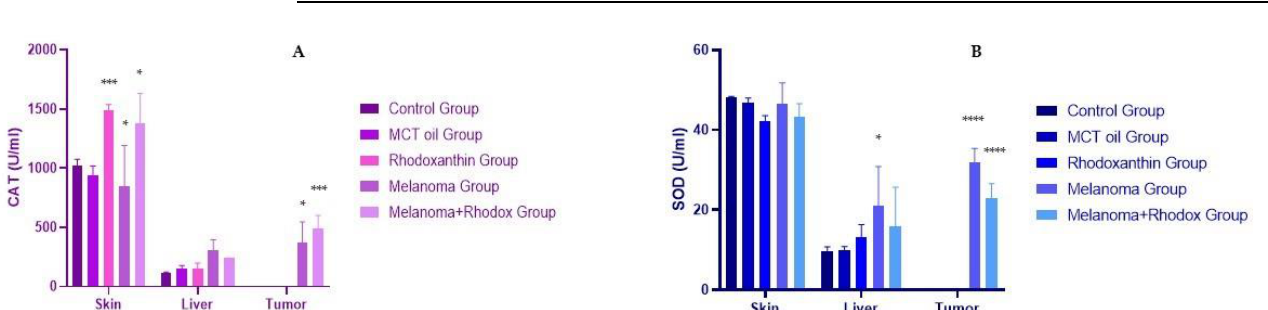
Figure 6. Enzymatic antioxidant activity of catalase ( A ) and superoxide-dismutase ( B ) in tissues. Val- ues are expressed as mean ± standard deviation SD from three independent experiments. Statistical significance level * p < 0.05, *** p < 0.01 and **** p < 0.0001.